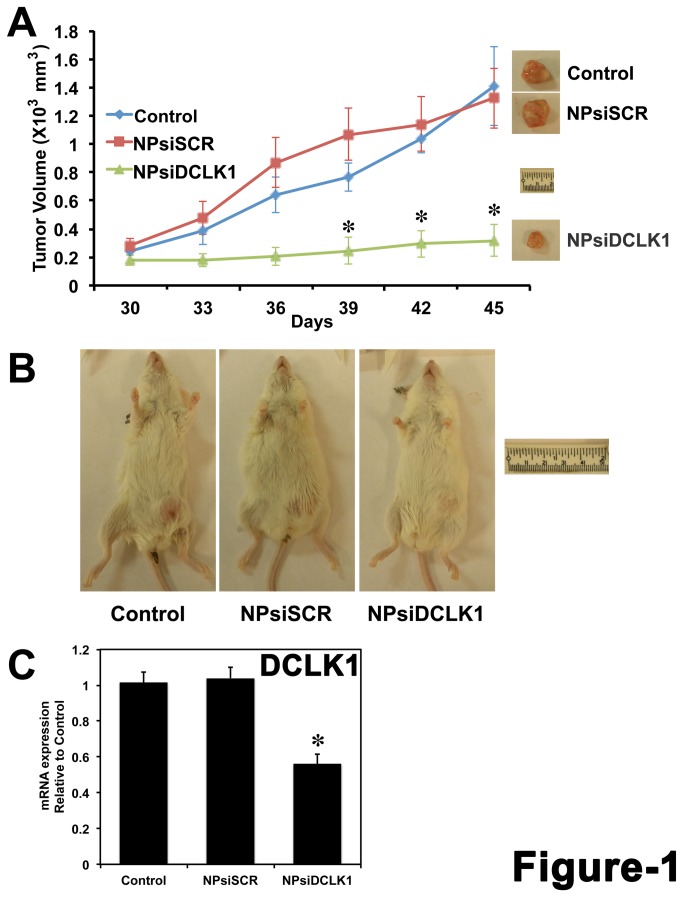
DCLK1 is essential for human pancreatic tumor xenograft growth.A, AsPC-1 human pancreatic cancer cells were subcutaneously injected into the flanks of NOD/SCID mice to generate tumors. At day 30, PLGA NP encapsulated siRNAs (siDCLK1 and siSCR) were injected directly into the tumors and followed by injections every third day. After 5 injections, tumors were excised at day 45 and are represented above. Tumor volume was measured every 3 days. B, Representative photograph of mice bearing the tumors from each group are shown. C, The expression of DCLK1 mRNA in the tumors quantitated by real-time RT-PCR. Values are given as average ± SEM, and asterisks denote statistically significant differences (*p < 0.01) compared with Control (NP alone).